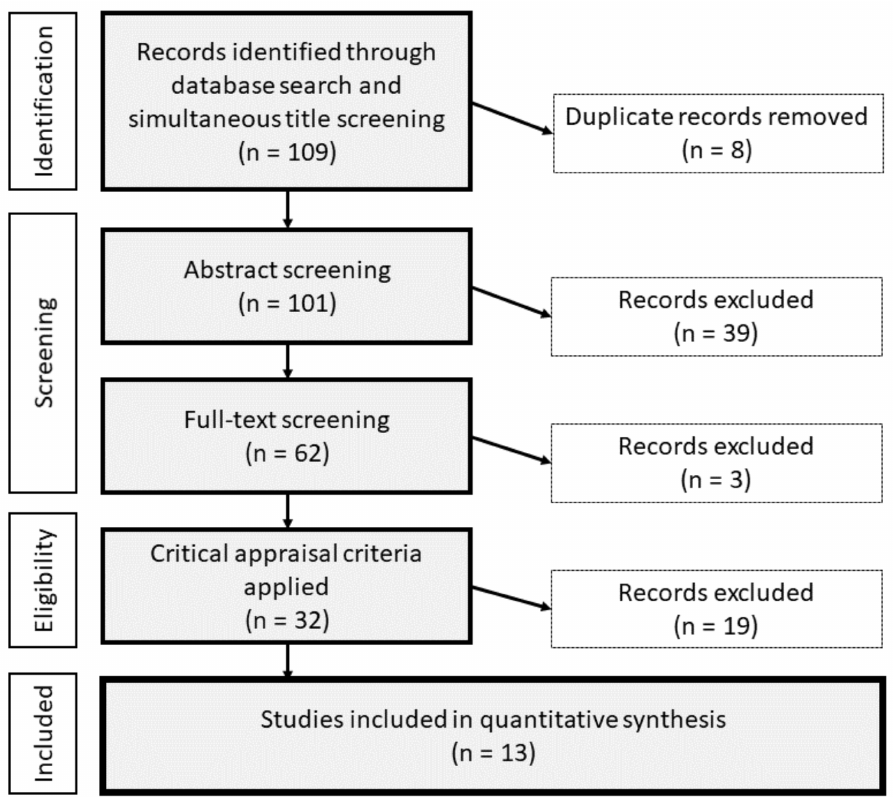
Figure 1. Steps outlining the systematic review process. Source: graph by the authors. After applying the above criteria to the dataset, 13 papers were finally selected and data on wood biomass, carbon stocks, and SOC stocks were extracted into an Excel file. Data were mainly reported as basal area (m 2 ha − 1 ), biomass (Mg ha − 1 ), and aboveground carbon stocks (Mg C ha − 1 ). Other information such as country of study, location, age of study sites, year(s) during which data was collected, geographical coordinates, elevation, MAP, and miombo type were included in the database. In addition, bibliographic information such as author, year of publication, reference, and study type was